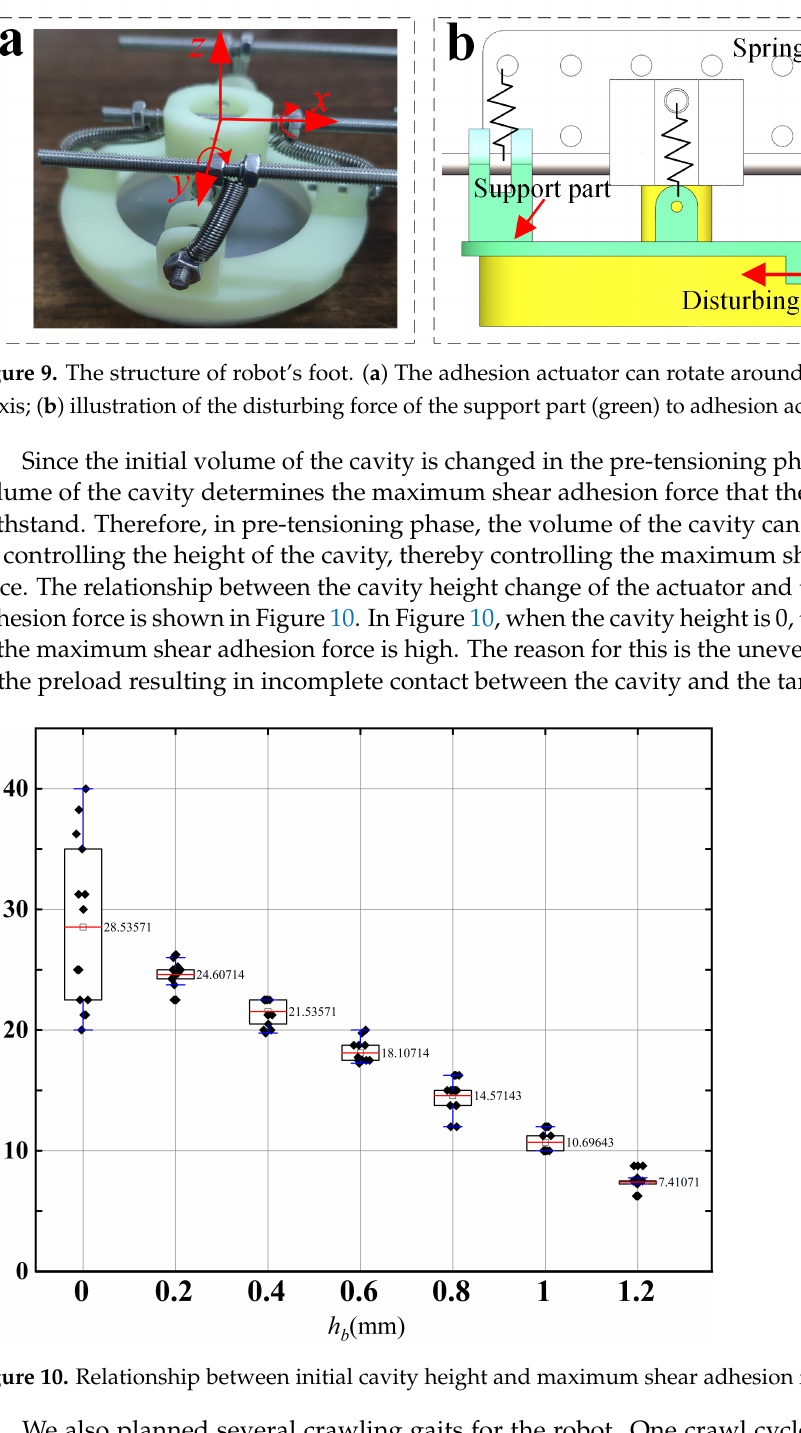
Figure 10. Relationship between initial cavity height and maximum shear adhesion